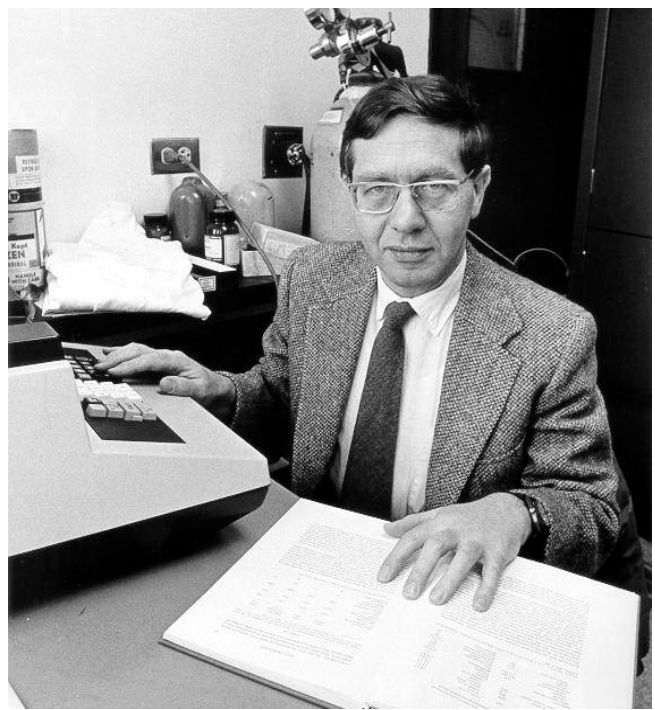
Figure 2. Dr. Louis Woolf in his office in Vancouver 1972 (from University of British Columbia Archives, Photographer Unknown [UBC 41.1/2188]) .